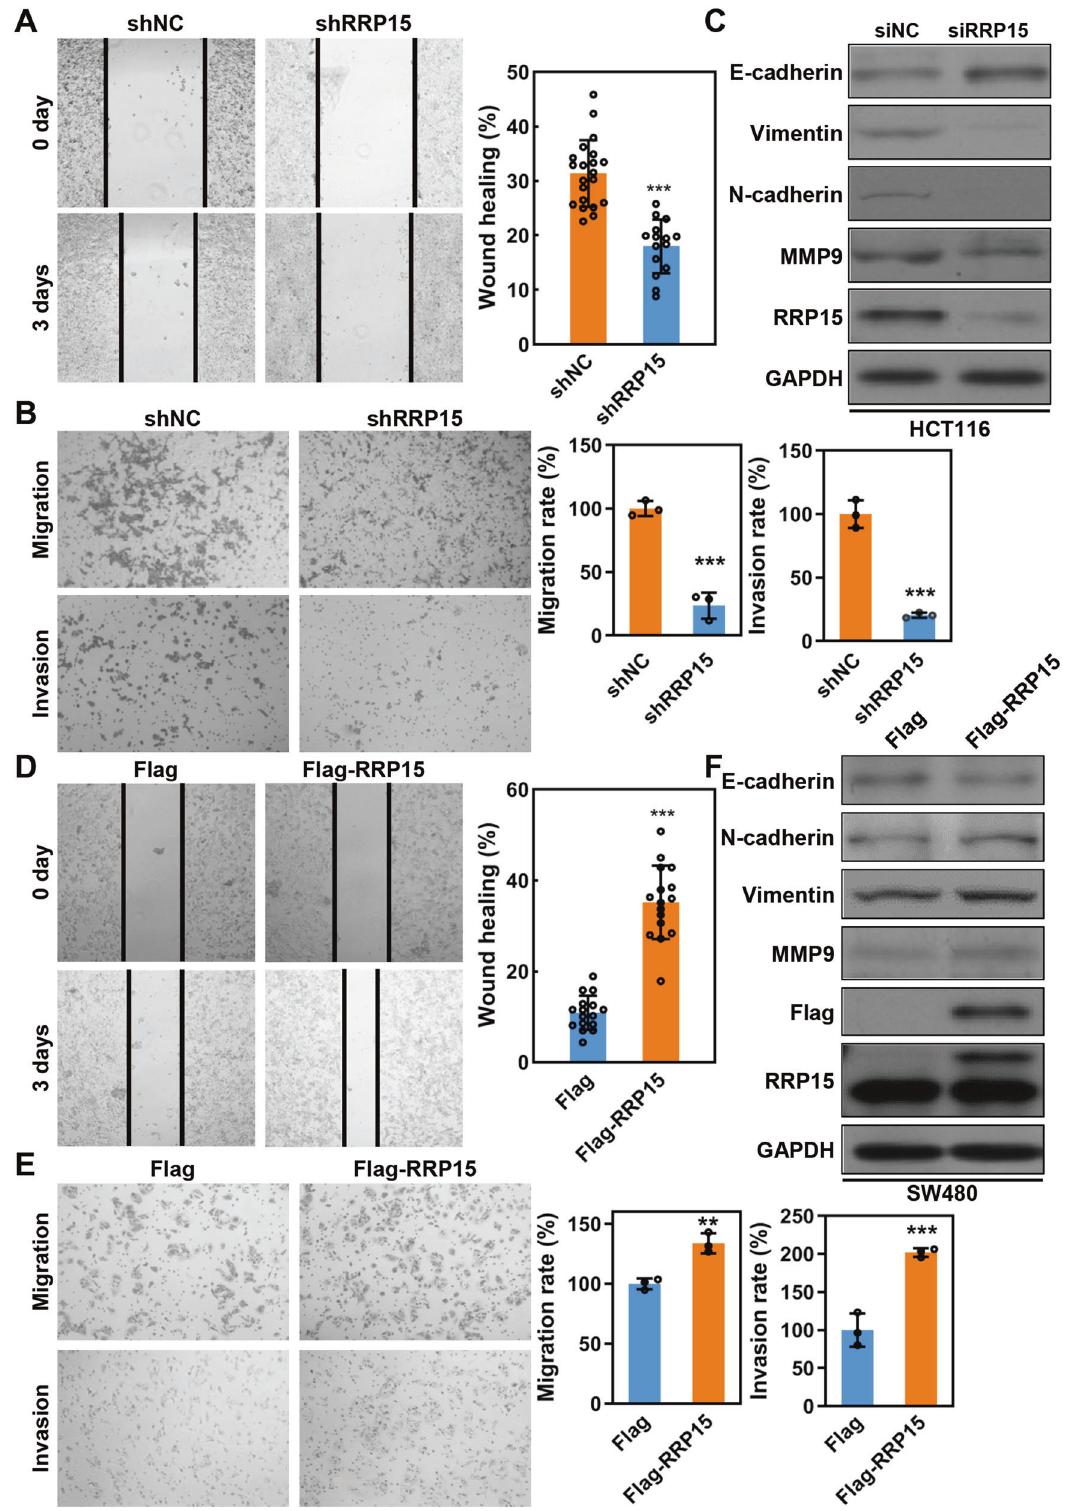
Fig. 3 RRP15 positively regulates migration and invasion of CRC cells. Wound healing assay ( A ), transwell migration and invasion assay ( B ) were used to assess the migratory and invasive ability of HCT116 cells with stably shRRP15 KD or controls. C Western blot for EMT-related proteins levels in HCT116 cells transfected with siNC or siRRP15. Wound healing assay ( D ), transwell migration and invasion assay ( E ) of SW480 cells with stably RRP15 OE and controls. F Western blot for EMT-related proteins levels in SW480 cells after RRP15 OE. All experiments were performed at least three times. Data are shown as mean ± standard deviations. ** P < 0.01 and *** P < 0.001.